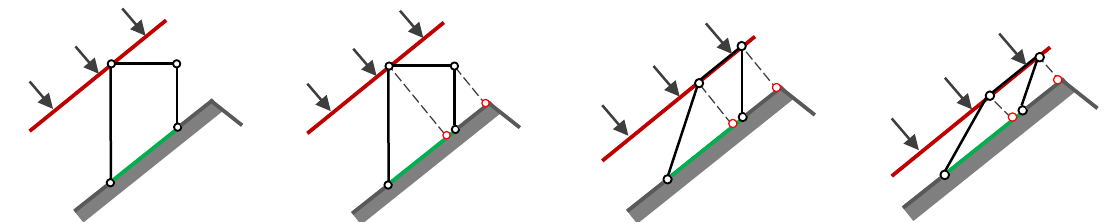
Figure 6. Projection of the eliminated building component onto the inclined joint plane in compliance with the Push Plane strategy (green – joint plane, red – transformation plane, black – eliminated component).